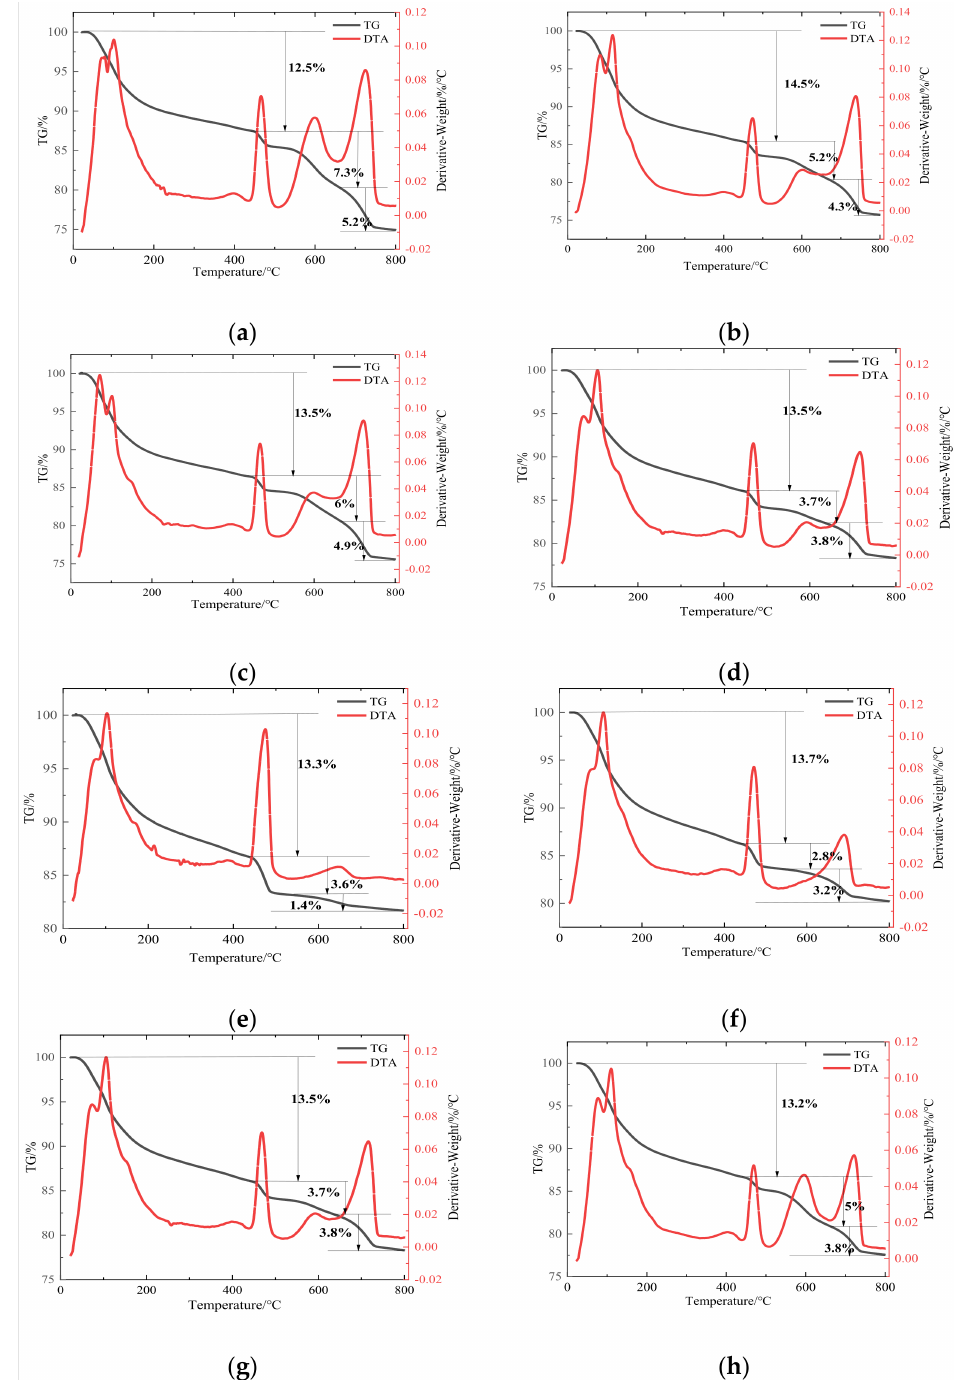
Figure 4. TG test result of each experimental group. ( a ) M − 1 group; ( b ) M − 2 group; ( c ) M − 3